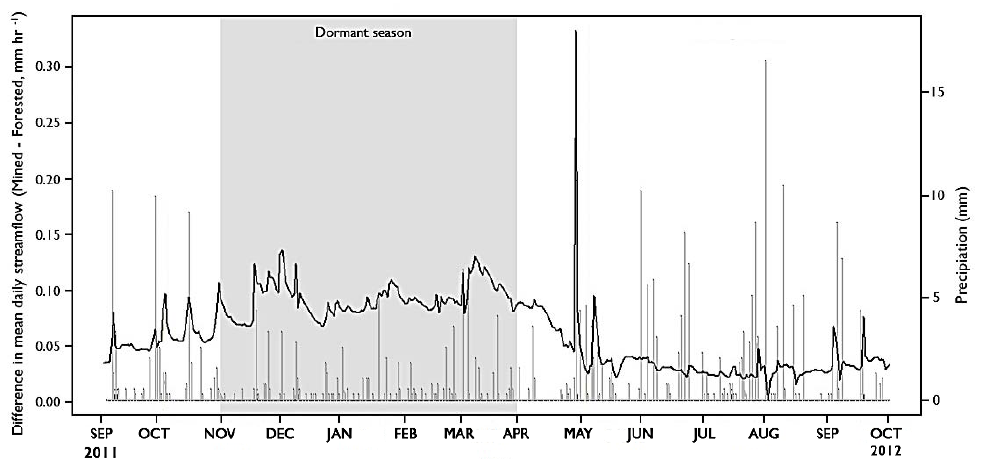
Figure 10. Runoff differences between the mined and forested catchment over the 13-month study period. The dormant season (November–April) is shaded. The greatest differences between catchments were during the dormant season, likely due to unaccounted for water from underground mine pools and inter-basin